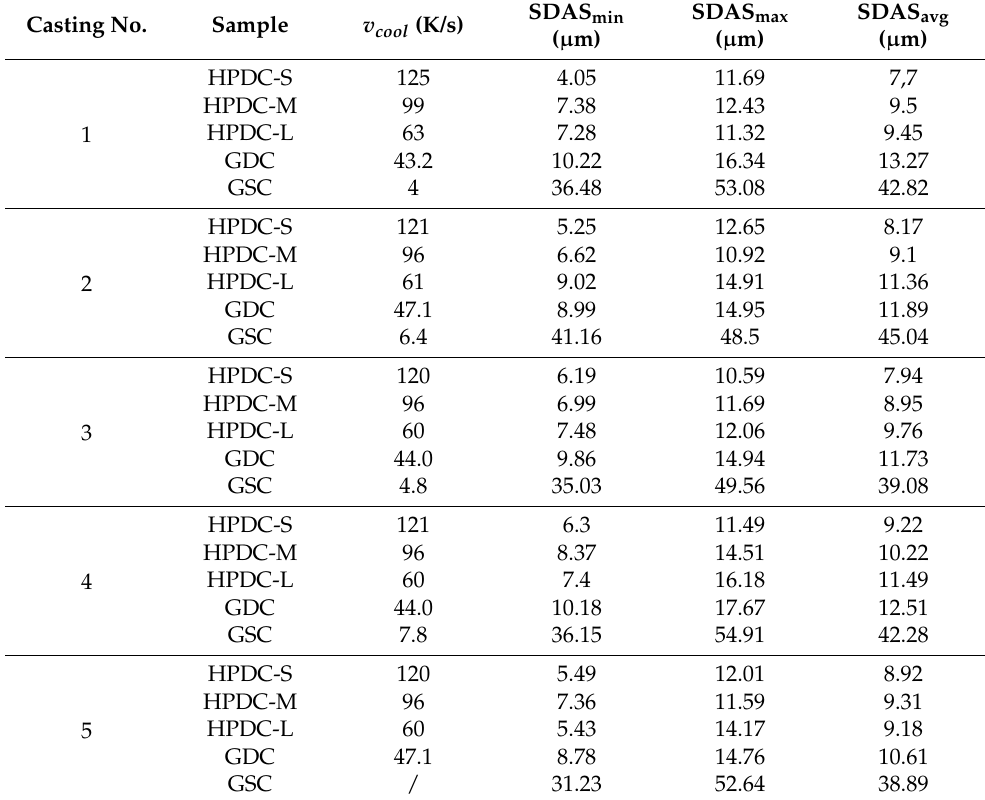
Table 3. Secondary dendrite arm spacing (SDAS) of all samples with dependence on cooling rate determined with numerical simulations. Casting